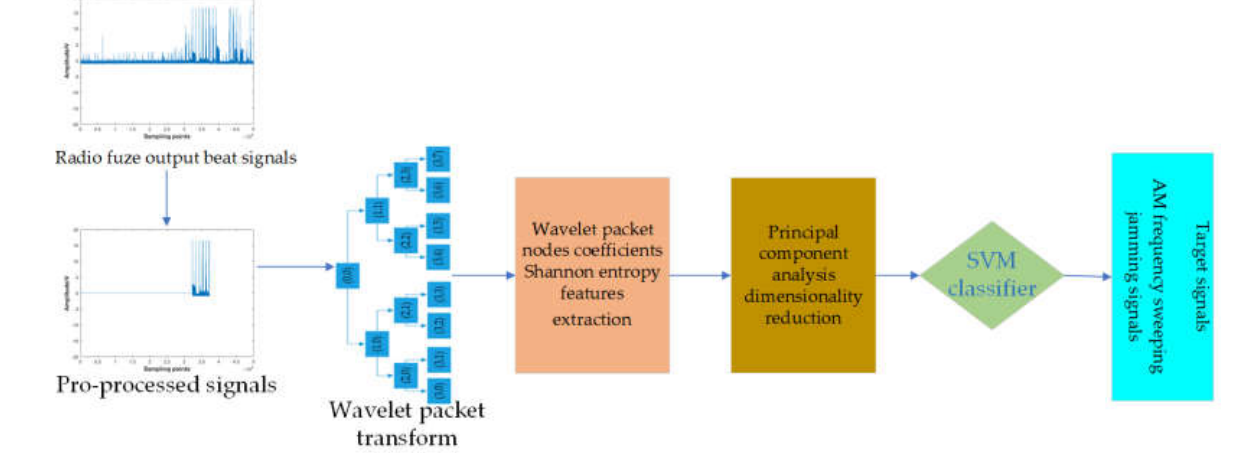
Figure 7. Flow chart of the target and jamming signals classification and identification method.